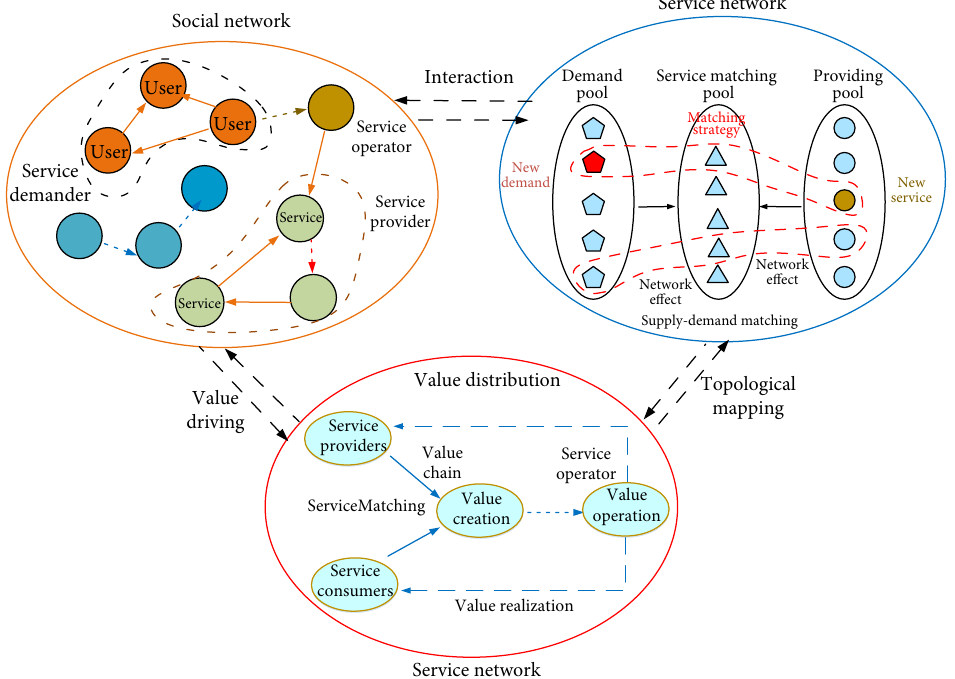
Fig. 7 Operation model of a service